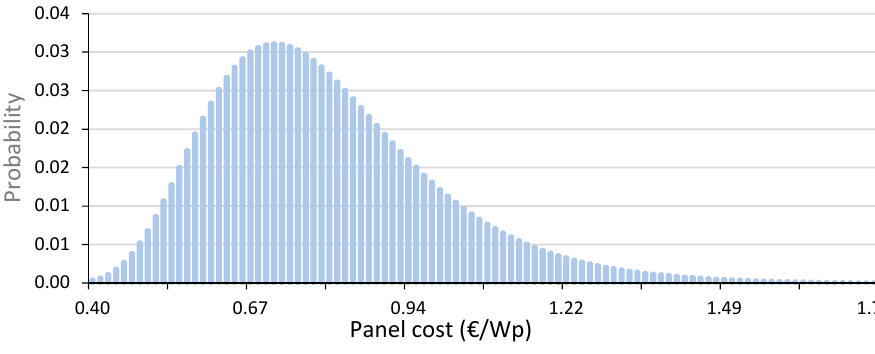
Figure 6. PDF of panel cost for a 5 kW system.